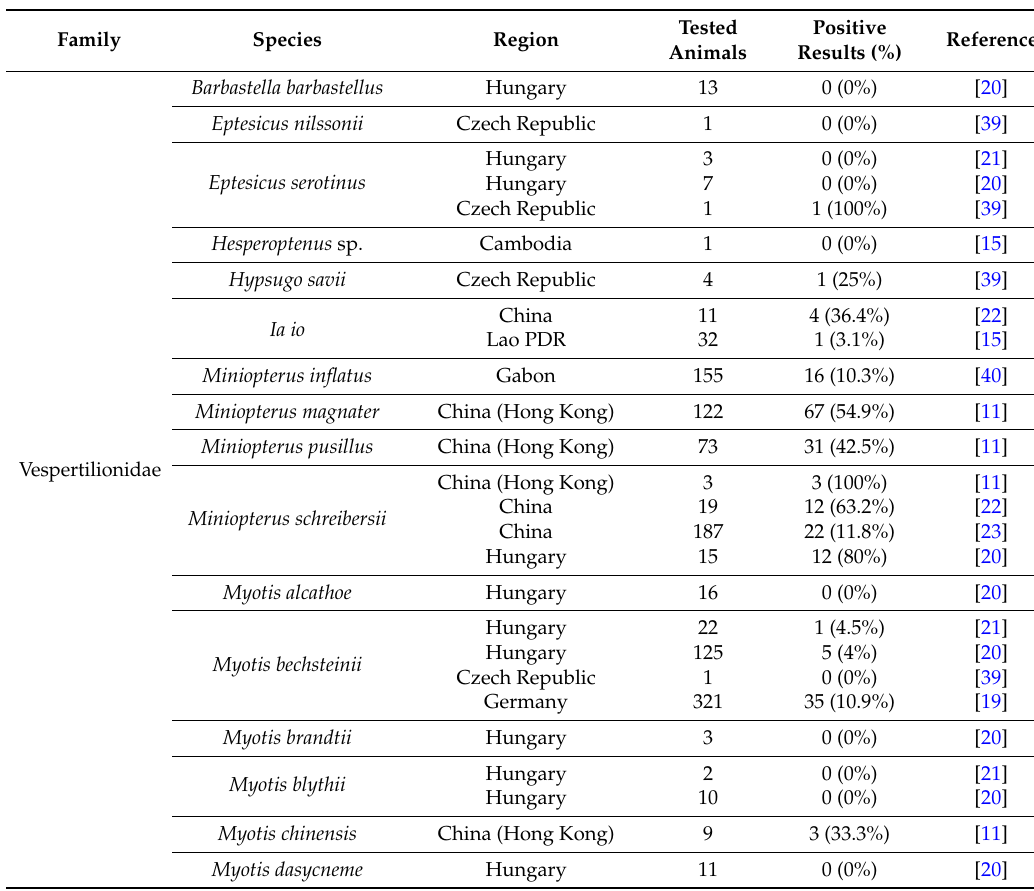
Figure 1. Geographic distribution of study sites for the detection of astrovirus ‐ related RNA in bats. All of the sampled bat families are depicted in colored dots in the respective countries where information on species, sample size and region was available. Source of map: [41]. Table 1. Species and number of bats that were investigated for the presence of astrovirus ‐ related RNA/genome by semi ‐ nested reverse transcription PCR (RT ‐ PCR).